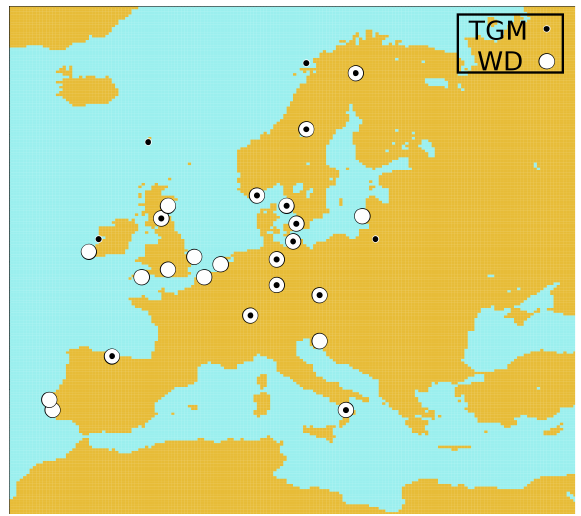
Figure 1. The model domain and location to the measurement sta- tions (white points for wet deposition (WD) and black points for TGM air